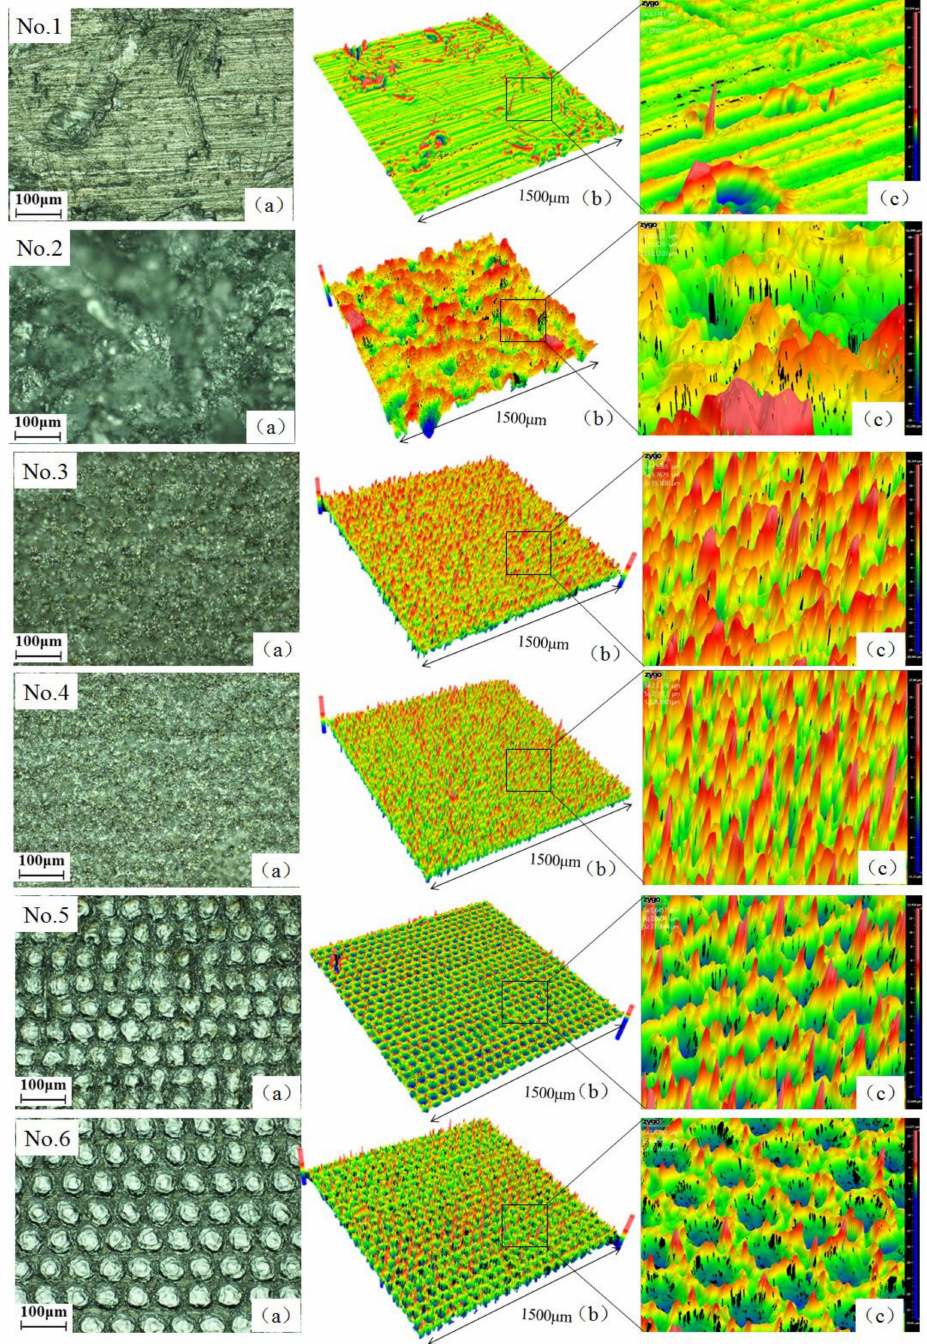
Figure 3. Topography and surface roughness test diagram of No.1–No.6 sample. ( a ) Topography was measured by optical microscope; ( b , c ) Surface roughness was measured by white light